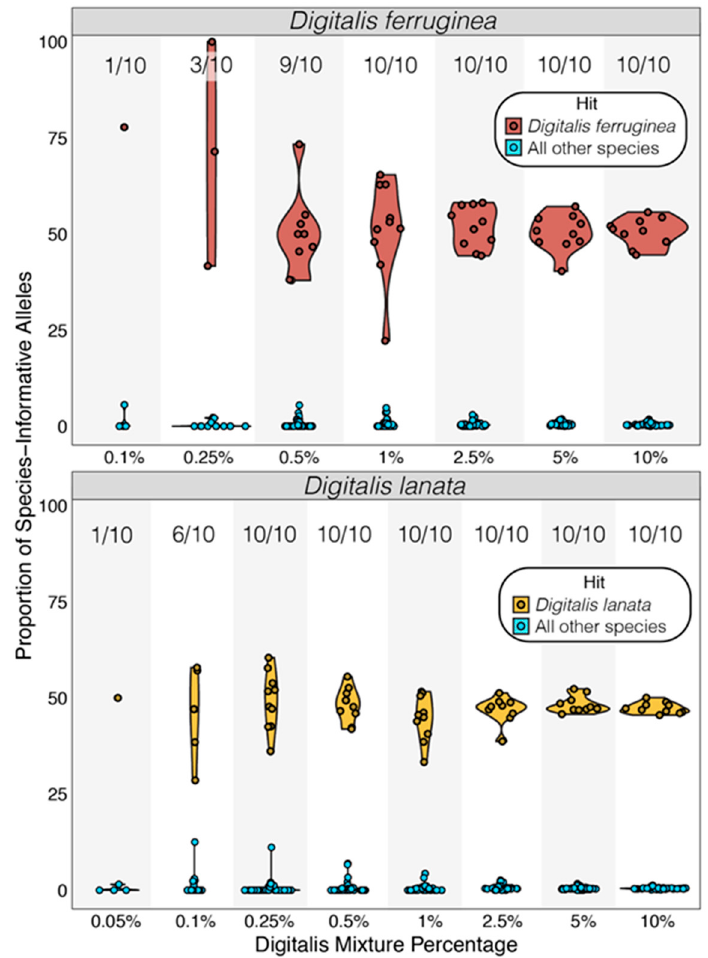
Figure 3. Accuracy of Digitalis species detection. For all mixture pseudoreplicates with sufficient data, the species of Digitalis was assigned based on the proportion of SNPs from each sample that contained species-informative alleles. In all cases the highest ratio of matching SNPs derived from the correct species, and all comparisons were significant based on modified Z-score analysis (all p ≤ 9.72 × 10 − 35 ). Proportions represent pseudoreplicates meeting the minimum data criteria. When Digitalis data accounted for 1% or more of the dataset (18.75 Mb), 10/10 pseudoreplicates could be identified, but limited data precluded robust species identification at some lower